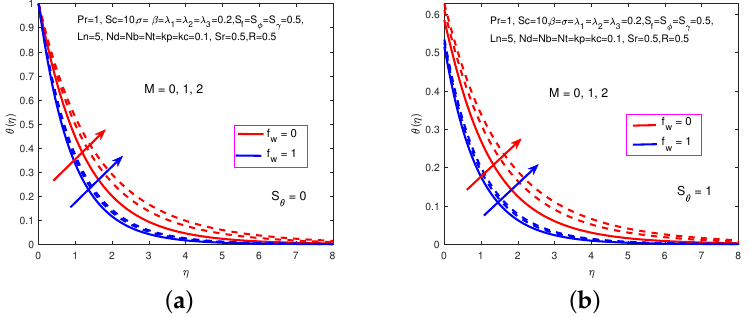
Figure 8. Influence of M and f w on θ . ( a ) No thermal slip. ( b ) With thermal slip.